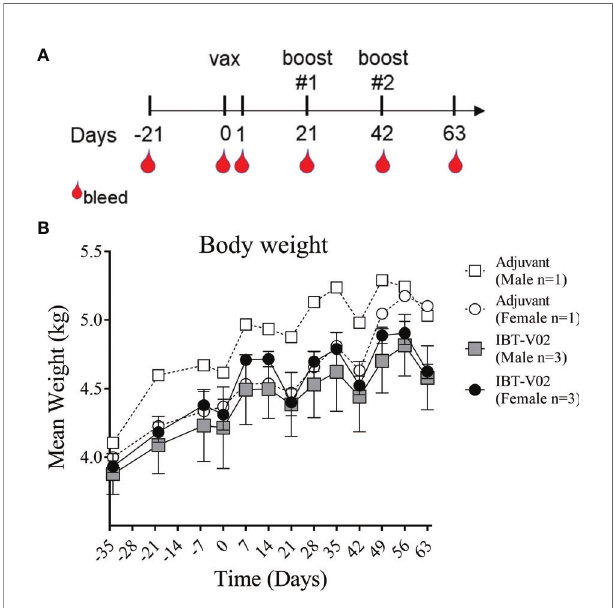
FIGURE 1 | Study Design and Body weight change. Vaccination (Days 0, 21, 42) and blood collection schedule of NHPs (A) . Mean weight of non-human primates (NHPs) measured at indicated time points relative to study start on day of 1st vaccination (D0), and on a weekly basis thereafter until day 63 (B) . Data was analyzed with GraphPad PRISM